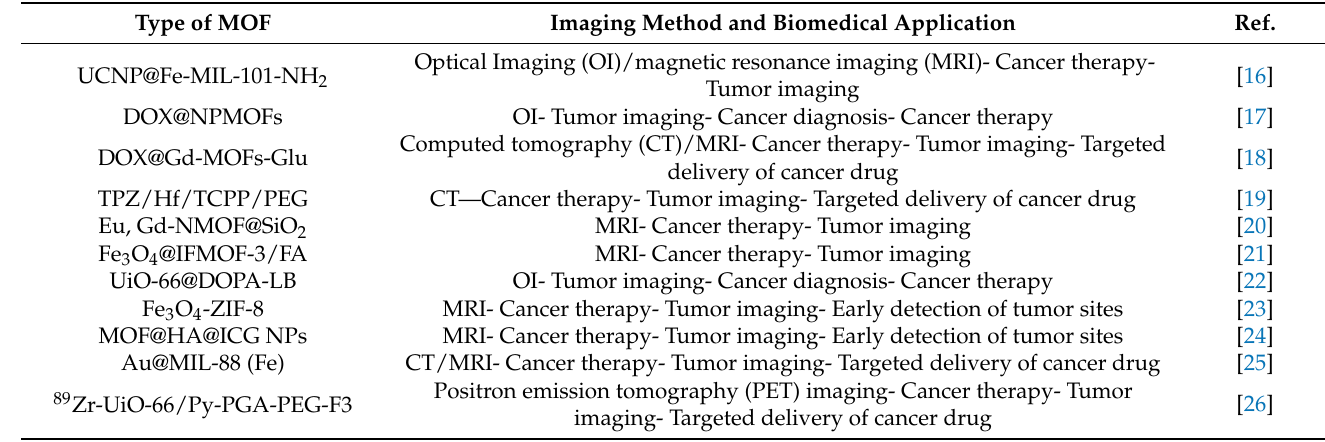
Table 1. MOF classification for bioimaging and related applications.